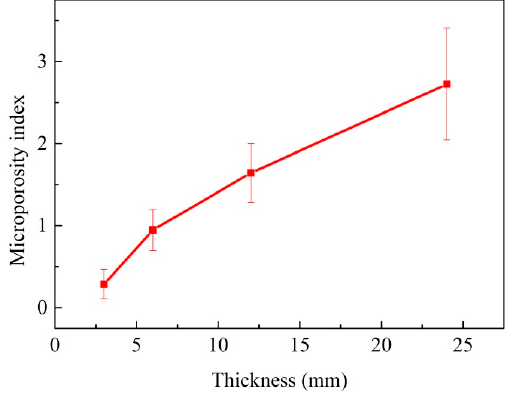
Figure 9. The volume fraction of microporosity as a function of the wall thickness.